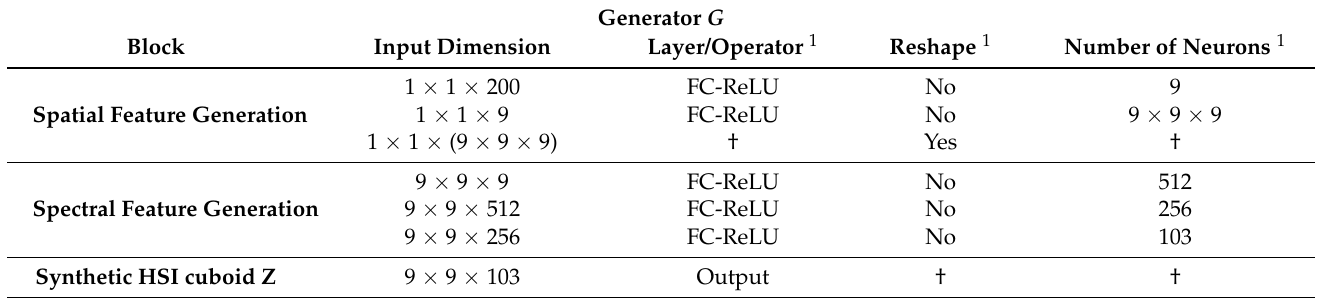
Table 1. Implementation details of the proposed generator G of the AWF 2 -GAN.